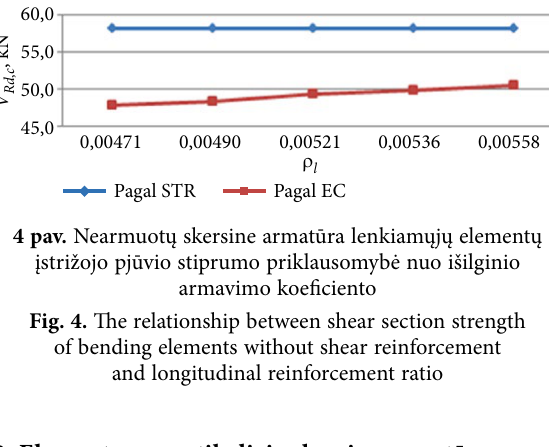
, in analysed section sl